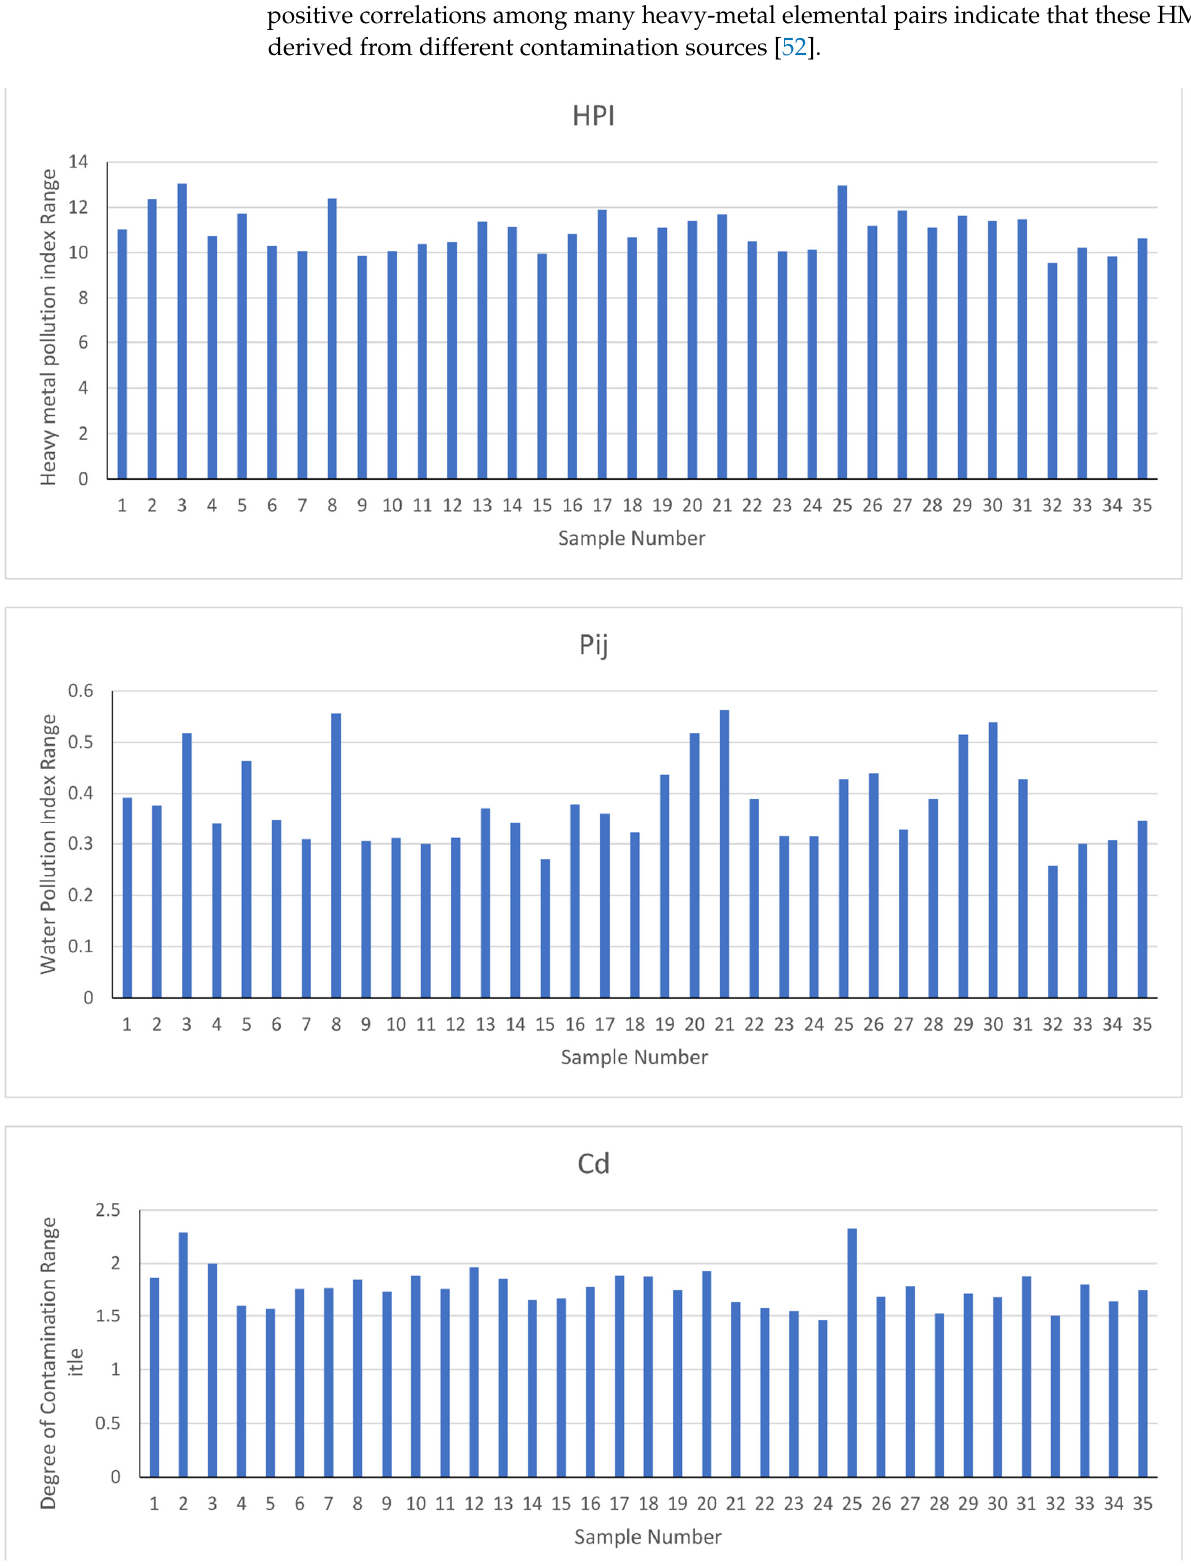
Figure 4. Q-mode HCA of Al-Ugair surface seawater samples.